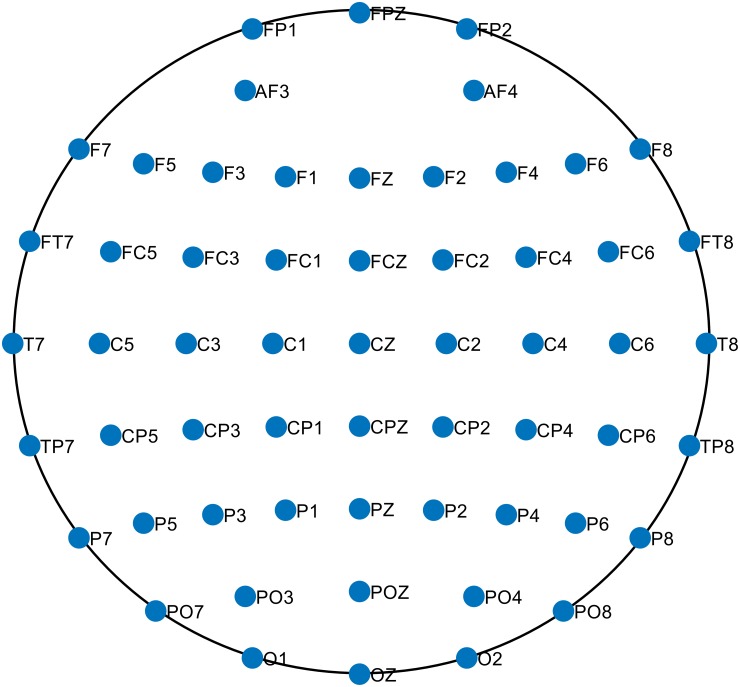
EEG channel locations used for constructing the FCNs.